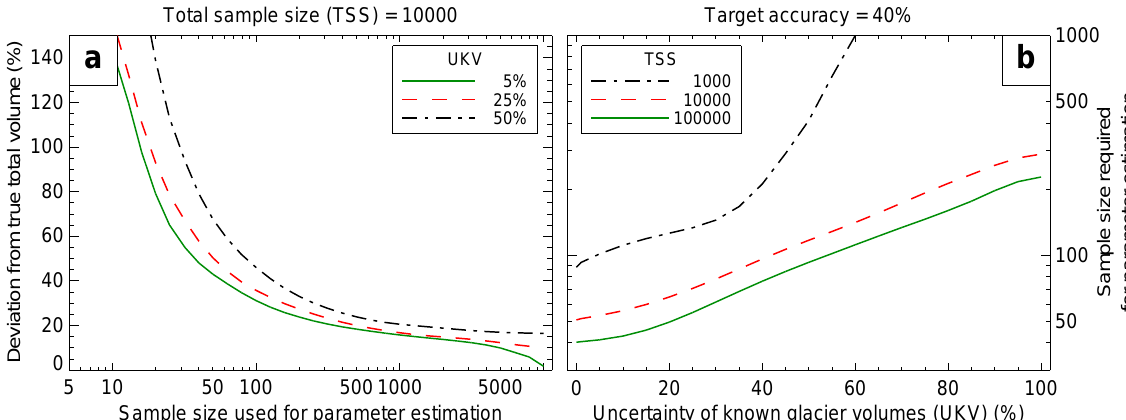
Fig. 1. (a) Accuracy (at the 95% confidence level) with which the true total volume of a population of 10000 glaciers is recovered through volume–area scaling (ordinate) if the parameters of the scaling relation are estimated by using a given number of measured (V,A)-pairs (abscissa). The different lines depict scenarios for different measurement uncertainties in glacier volume. (b) Sample size required for estimating the parameters of the scaling relation in order to recover the true total volume of a glacier population within 40% accuracy (95% confidence level). The result is given as a function of the uncertainty in the measured volumes. The different lines show the result for different sizes of the glacier population for which the total volume is